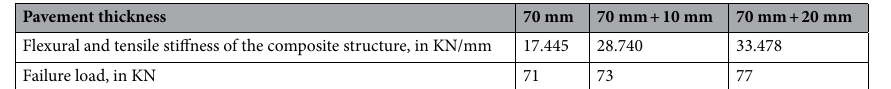
Pavement thickness